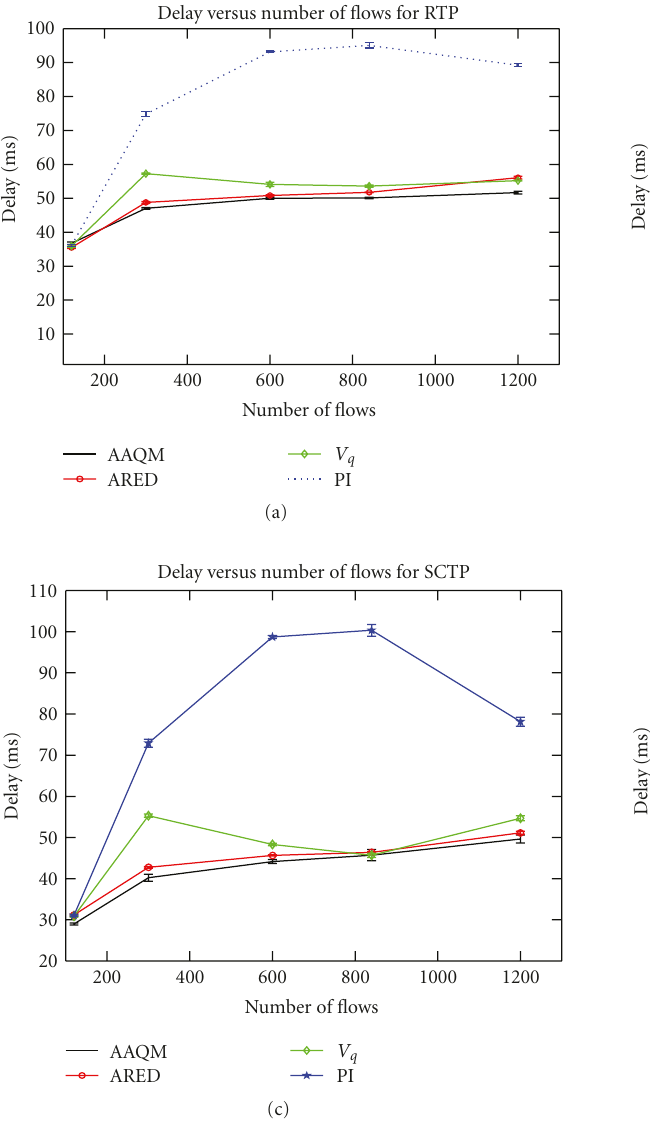
Figure 12: Delay for (a) Video Tra ffi c (b) Multimedia tra ffi c (e.g., Voip) (c) SCTP Tra ffi c (d) TCP Tra ffi